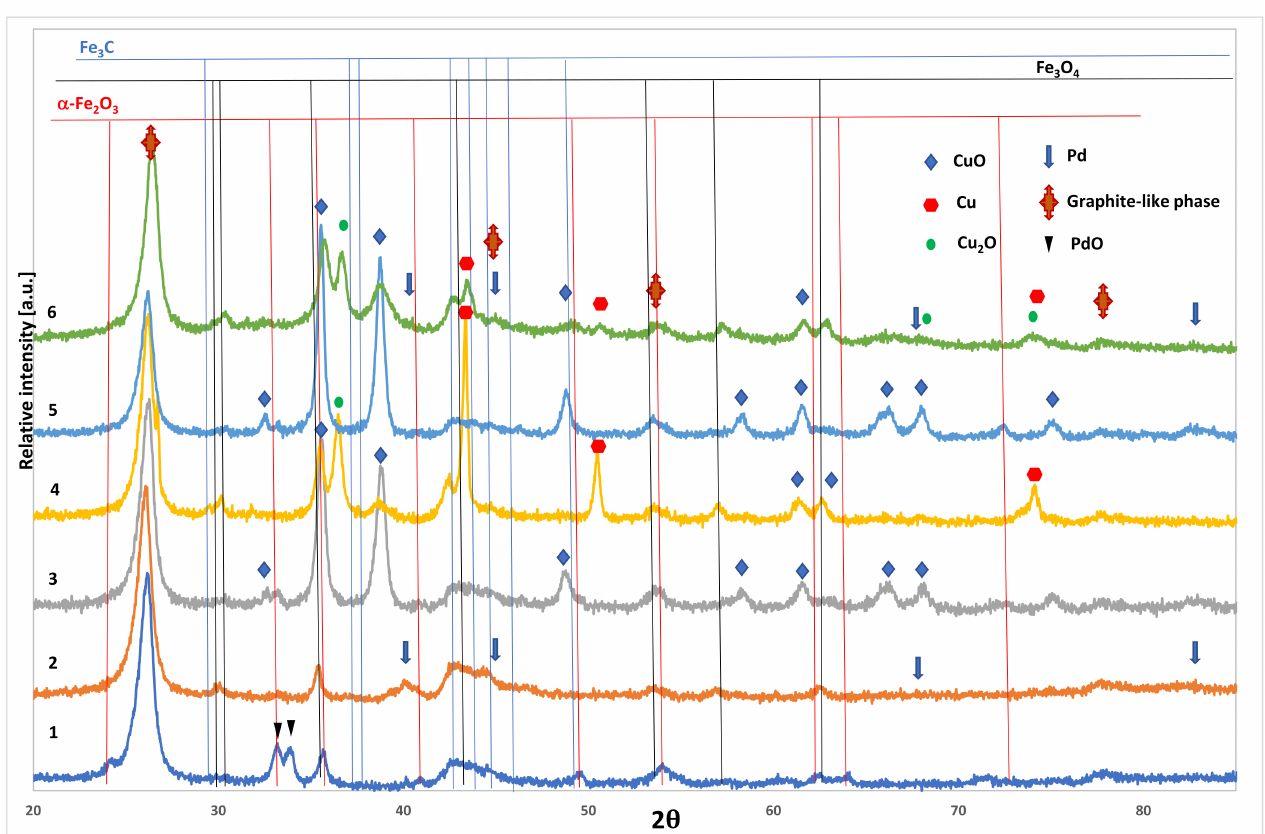
Figure 2. The XRD diffractograms for the monometallic Pd and Cu and the bimetallic Pd-Cu supported catalysts calcined under static air for 4 h at 350 ◦ C and after steam reforming of methanol reaction: (1) 1%Pd/MWCNTs calcined under static air at 350 ◦ C for 4 h, (2) 1%Pd/MWCNTs after SRM process, (3) 20%Cu/MWCNTs calcined under static air at 350 ◦ C for 4 h, (4) 20%Cu/MWCNTs after SRM process, (5) 1%Pd-20%Cu/MWCNTs calcined under static air at 350 ◦ C for 4 h, and (6) 1%Pd-20%Cu/MWCNTs after SRM